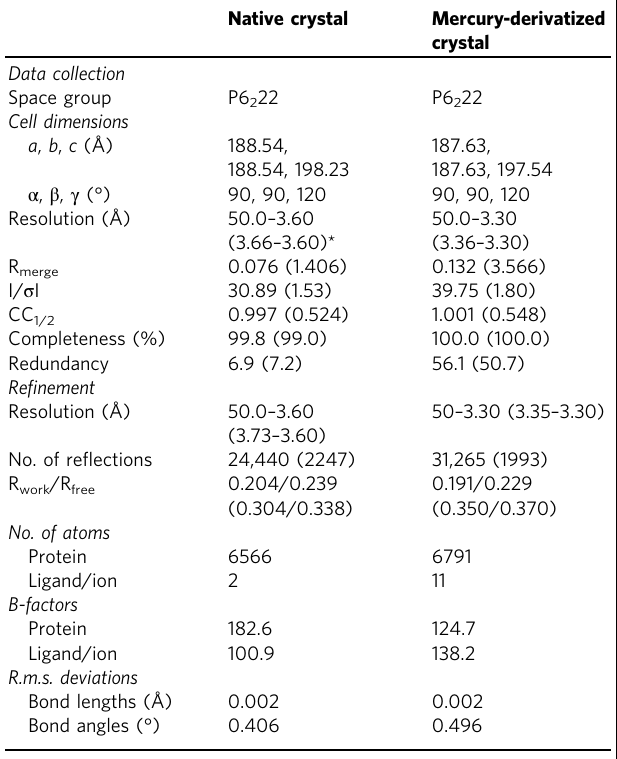
Table 1 Data collection and structure re fi nement